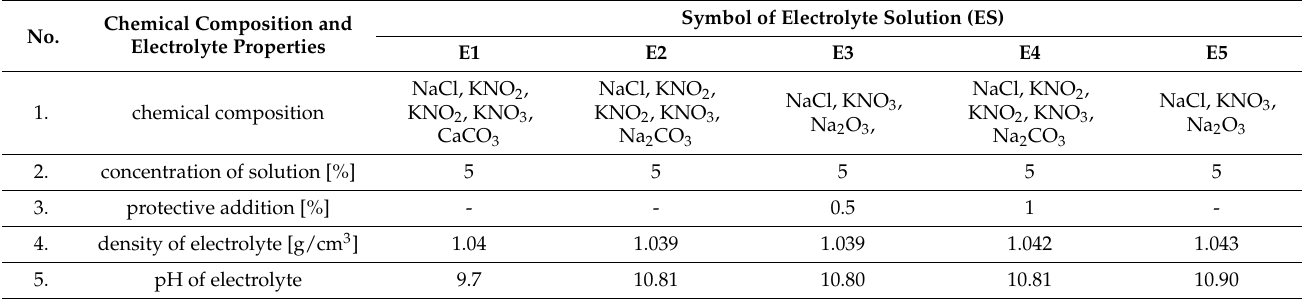
Table 2. Physicochemical properties of electrolytes